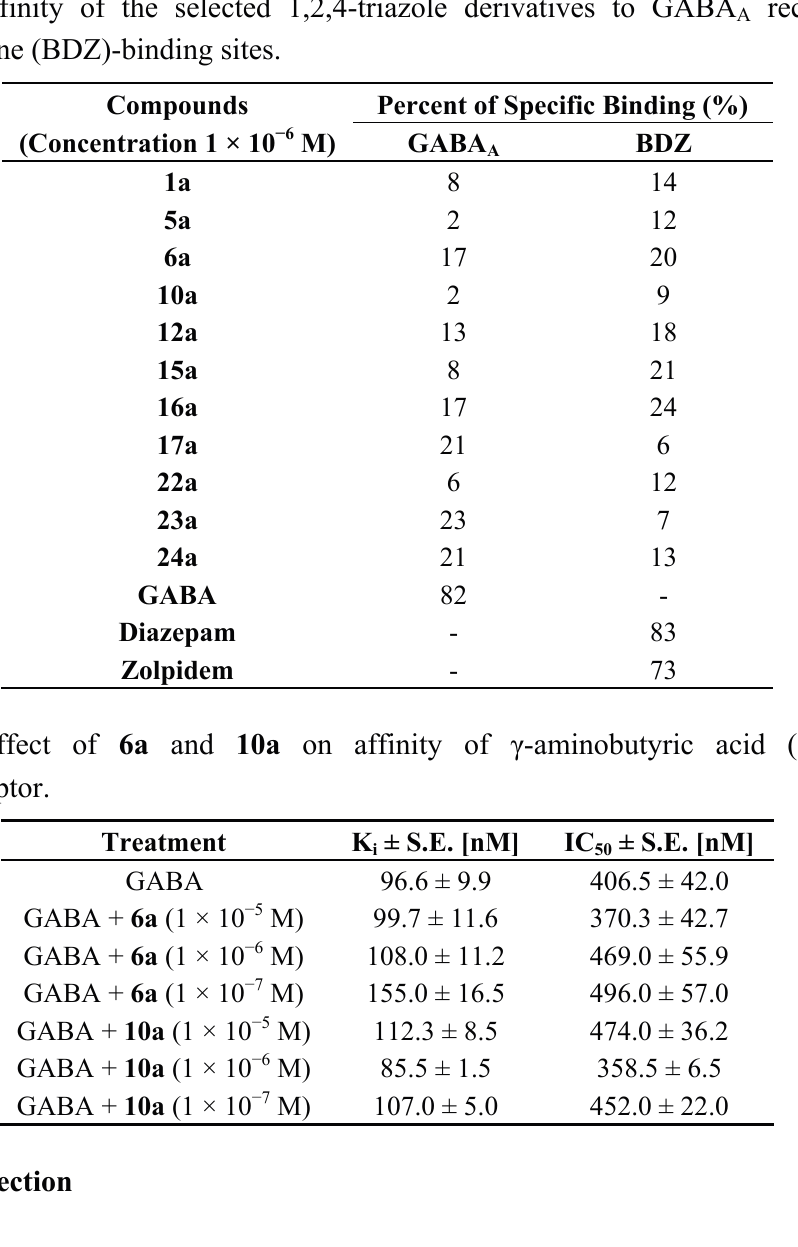
receptors and A